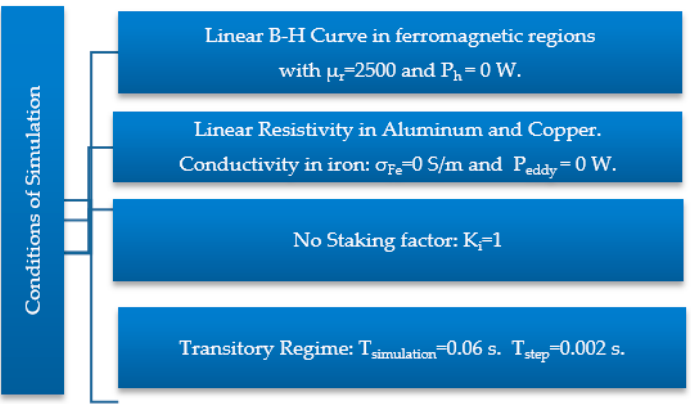
Figure 8. Simulation conditions imposed during the simulation.